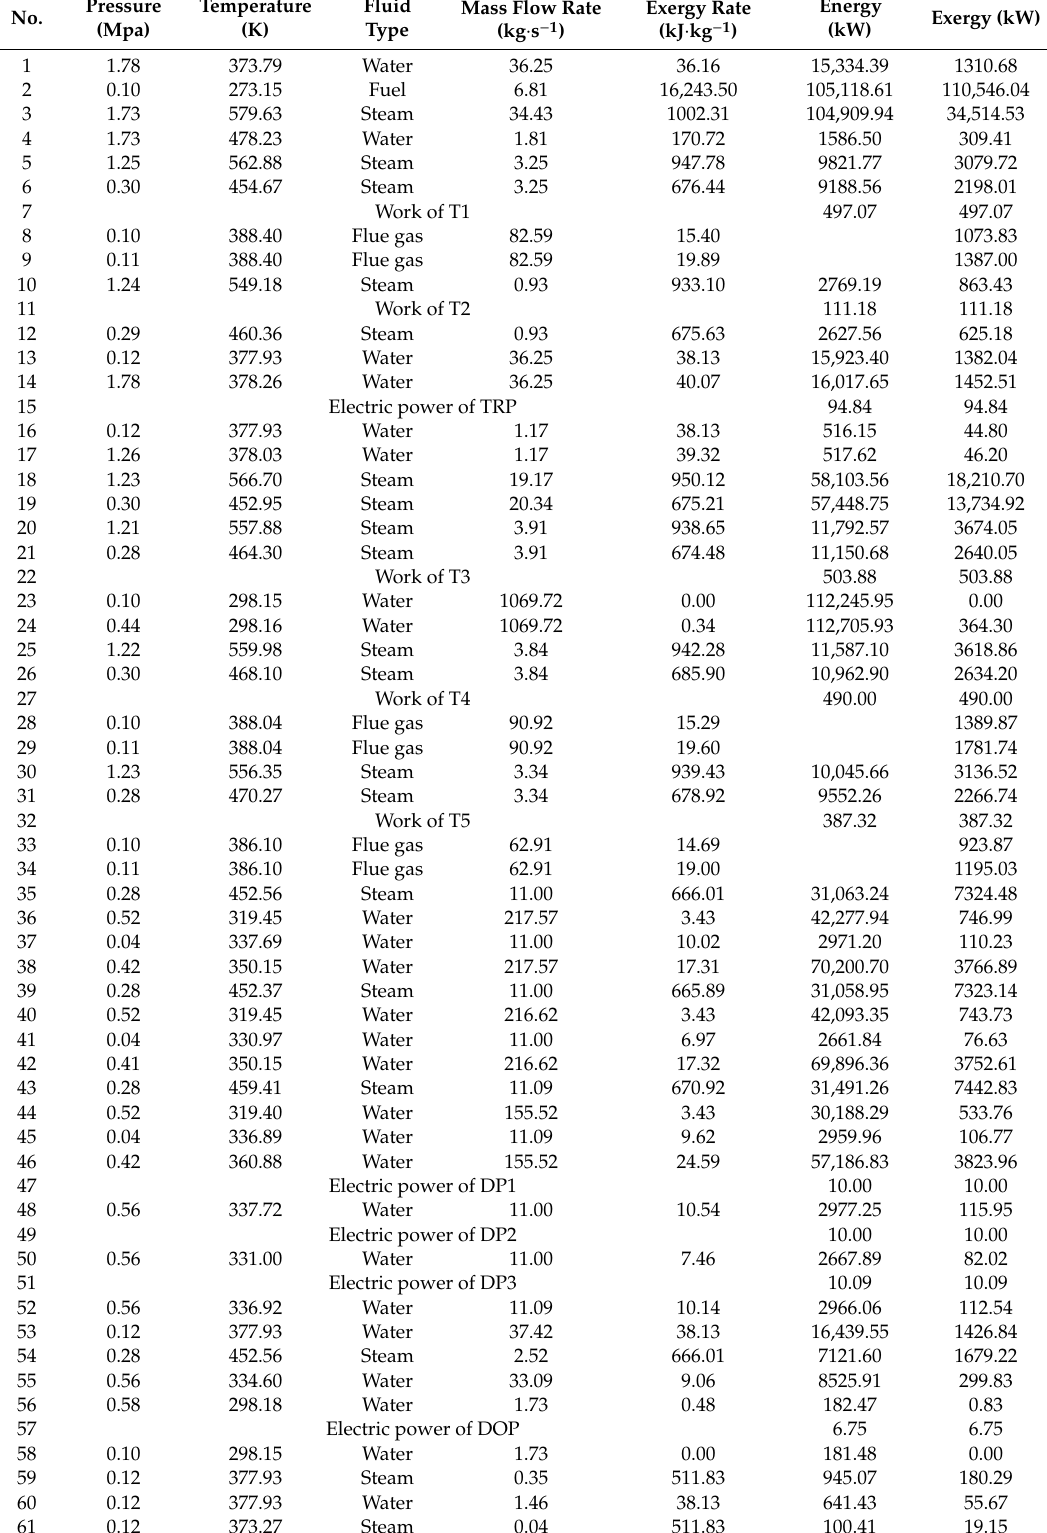
Table A3. Properties of streams at each state